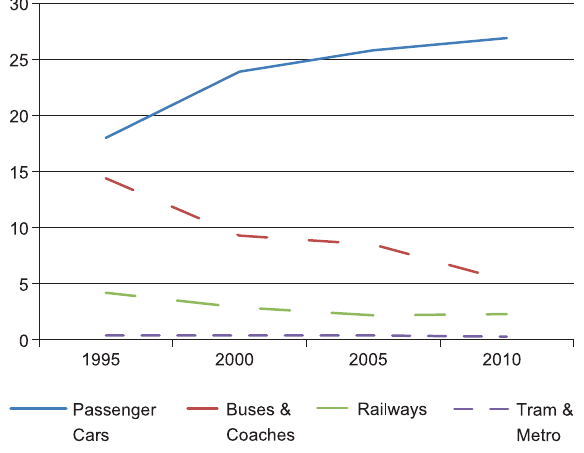
Fig. 4. Performance of passenger transport expressed in passenger-kilometres in Slovakia. Source: EU transport in figures, Statistical Pocketbook 2012.